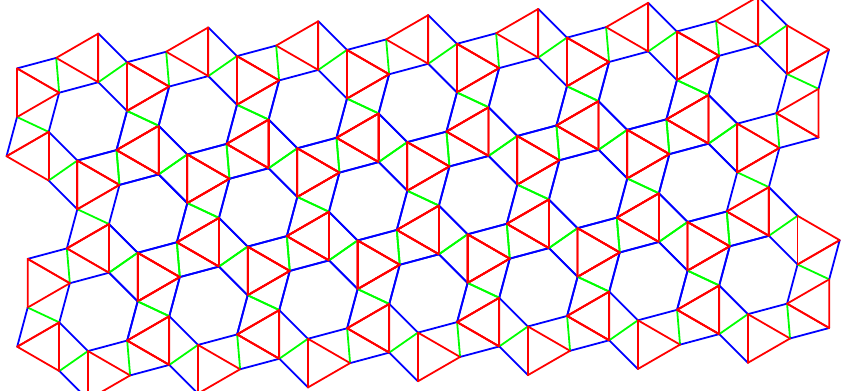
Fig. 24: Tiling with regular hexagon, regular triangle and an arbitrary triangle